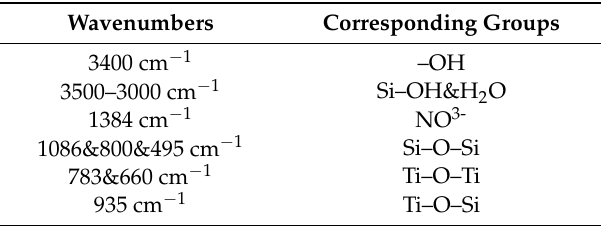
Figure 3. FTIR spectra of SCF, TCF, and STCF. Table 1. Wavenumbers of absorption peak for main